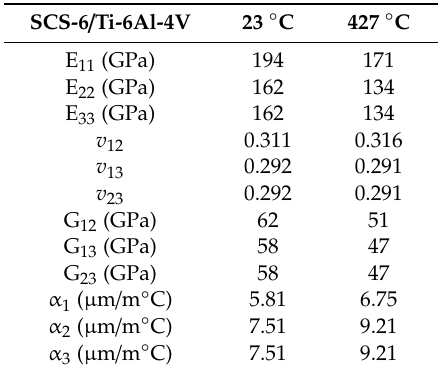
Figure 8. Finite element mesh of a composite specimen used in global analysis. Table 4. Global stress analysis results for unit-applied stress. Table 3. Linear micromechanics analysis